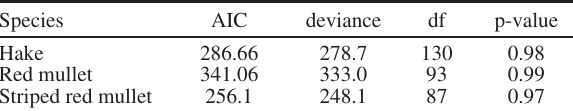
Table 3. – Fit statistics for the catch comparison curves; df, degrees of freedom; AIC, Akaike information criterion. Species AIC